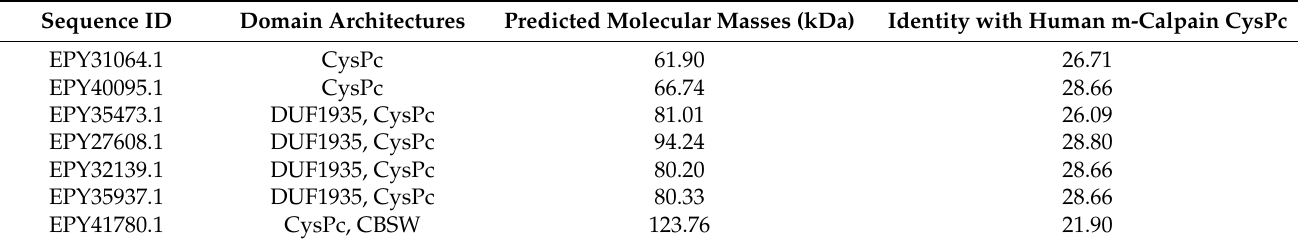
Table 3. Calpain sequences with the conserved catalytic triad (C,H,N) from Angomonas deanei